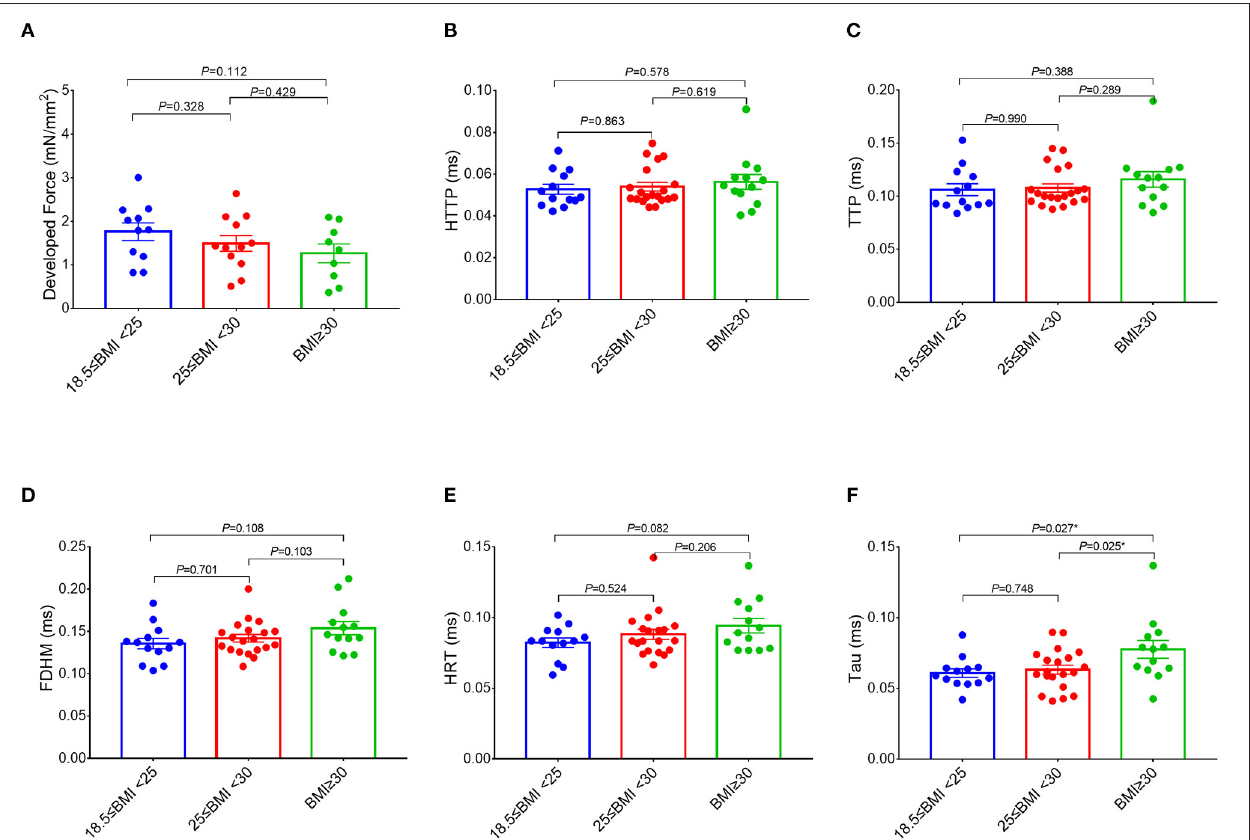
FIGURE 2 | Comparisons of the measurements of the right atrial trabeculae function between the groups. The developed force of the right atrial trabeculae of 32 patients (normal group: n = 11; overweight group: n = 12; obese group: n = 9) was analyzed (A) and the rest of the parameters of the right atrial trabeculae of 46 patients (normal group: n = 13; overweight group: n = 20; obese group: n = 13) was analyzed (B–F) . Compared with the obese group (BMI ≥ 30 kg/m 2 ), Tau in both the overweight group (25 kg/m 2 ≤ BMI < 30 kg/m 2 ) and the normal group (18.5 kg/m 2 ≤ BMI < 25 kg/m 2 ) is significantly lower, but no significant differences on the rest of the parameters of the right atrial trabeculae function between the three groups. * Compared to the obese group (BMI ≥ 30 kg/m 2 ), p < 0.05. Data are expressed as mean ± SEM. BMI, body mass index; HTTP, half time to peak; TTP, time to peak; FDHM, full duration at half maximum; HRT, half relaxation time; Tau, relaxation time